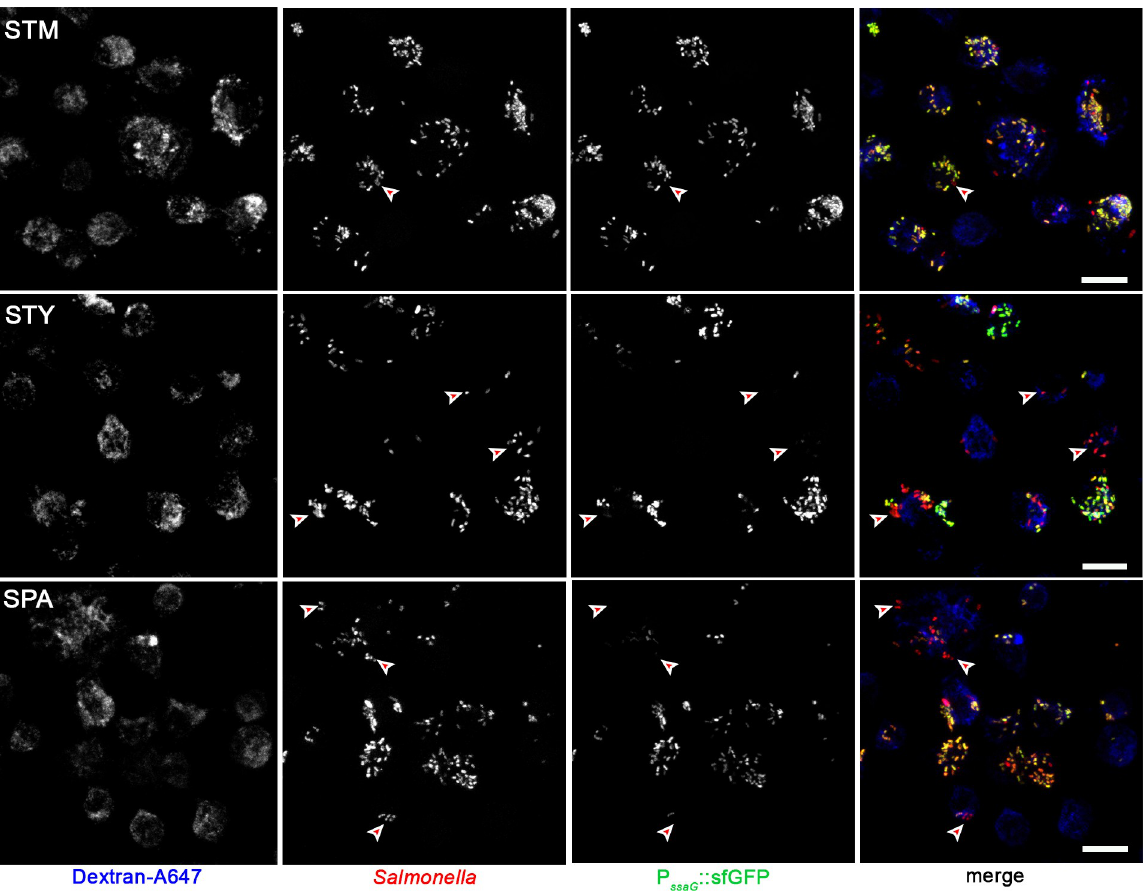
Fig 2. Heterogeneity of P ssaG induction by intracellular STM, SPA and STY. U937 cells were infected at MOI 50 with STM, STY, or SPA WT strains all harboring plasmid p3776 for constitutive expression of RFP (red), and sfGFP (green) under control of the ssaG promoter. To label the endosomal system, cells were pulsed with dextran-Alexa647 (dextran-A647, blue) from 1 h p.i. until fixation. Cells were fixed with PFA 8 h p.i. and microscopy was performed by CLSM on a Leica SP5 using a 40x objective. Red arrowheads indicate representative, P intracellular Salmonella . Scale bars: 10 μ